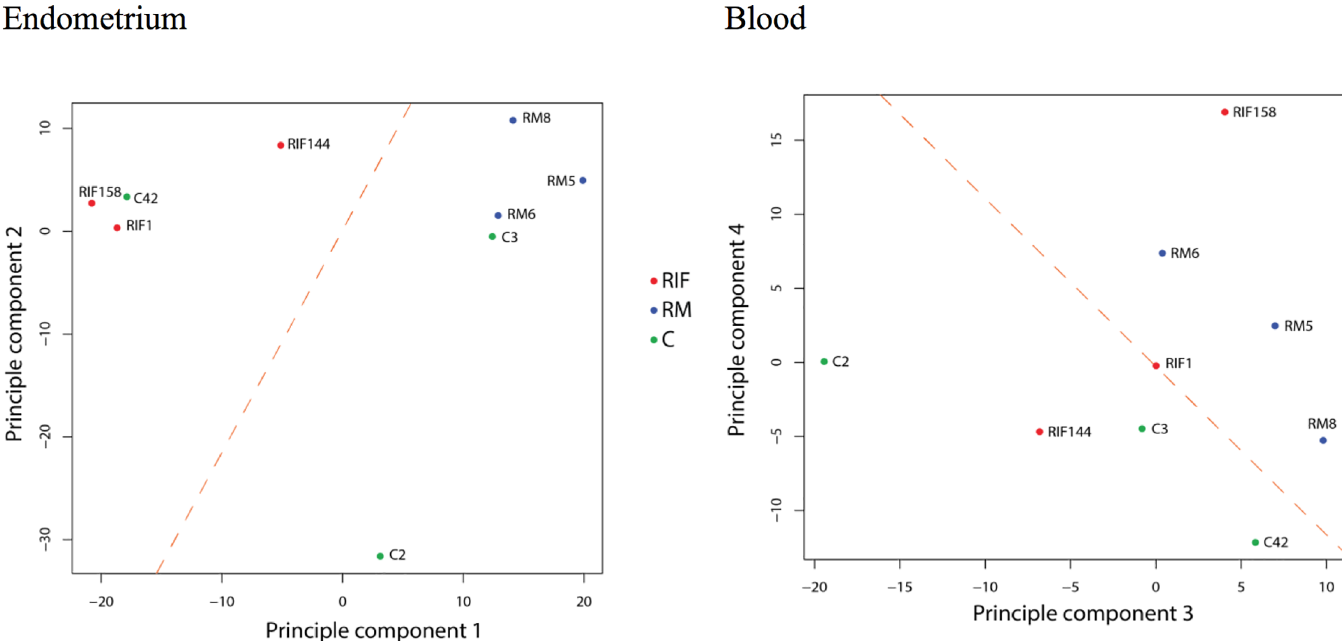
Fig 2. Linear separations of RIF, RM and control on principle component analysis (PCA) by support vector machine (SVM). RIF: recurrent implantationfailure; RM: recurrent miscarriage; C: fertile control.